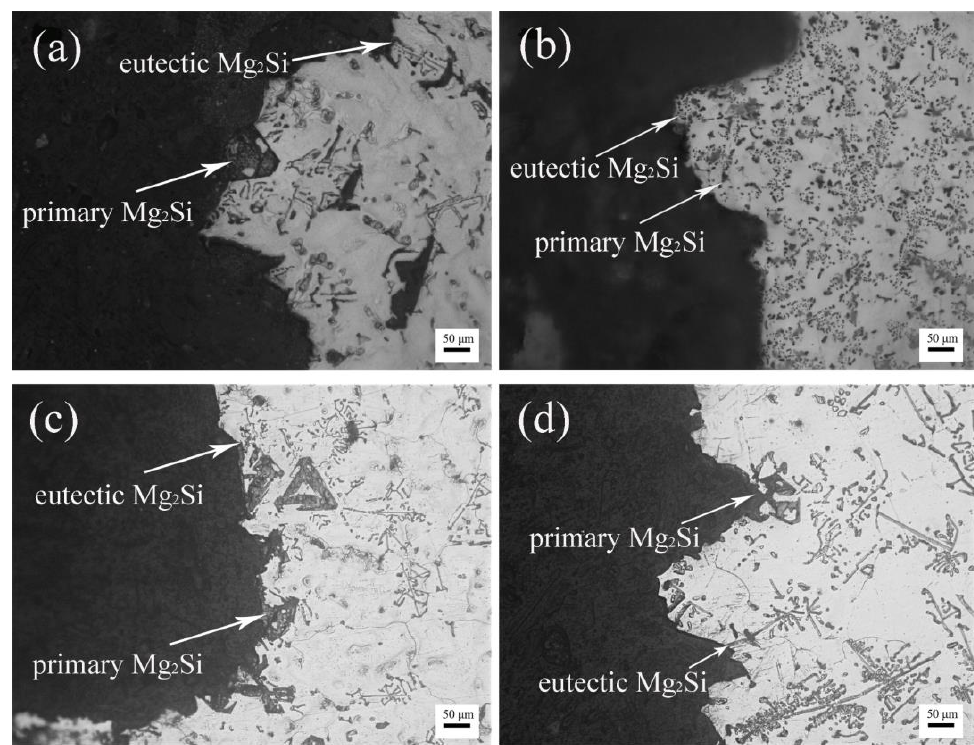
Figure 13. Side-views of fracture surfaces of the as-cast composites ( a ); the solution-treated composites ( b ); the as-cast alloys ( c ); and the solution-treated alloys ( d ).